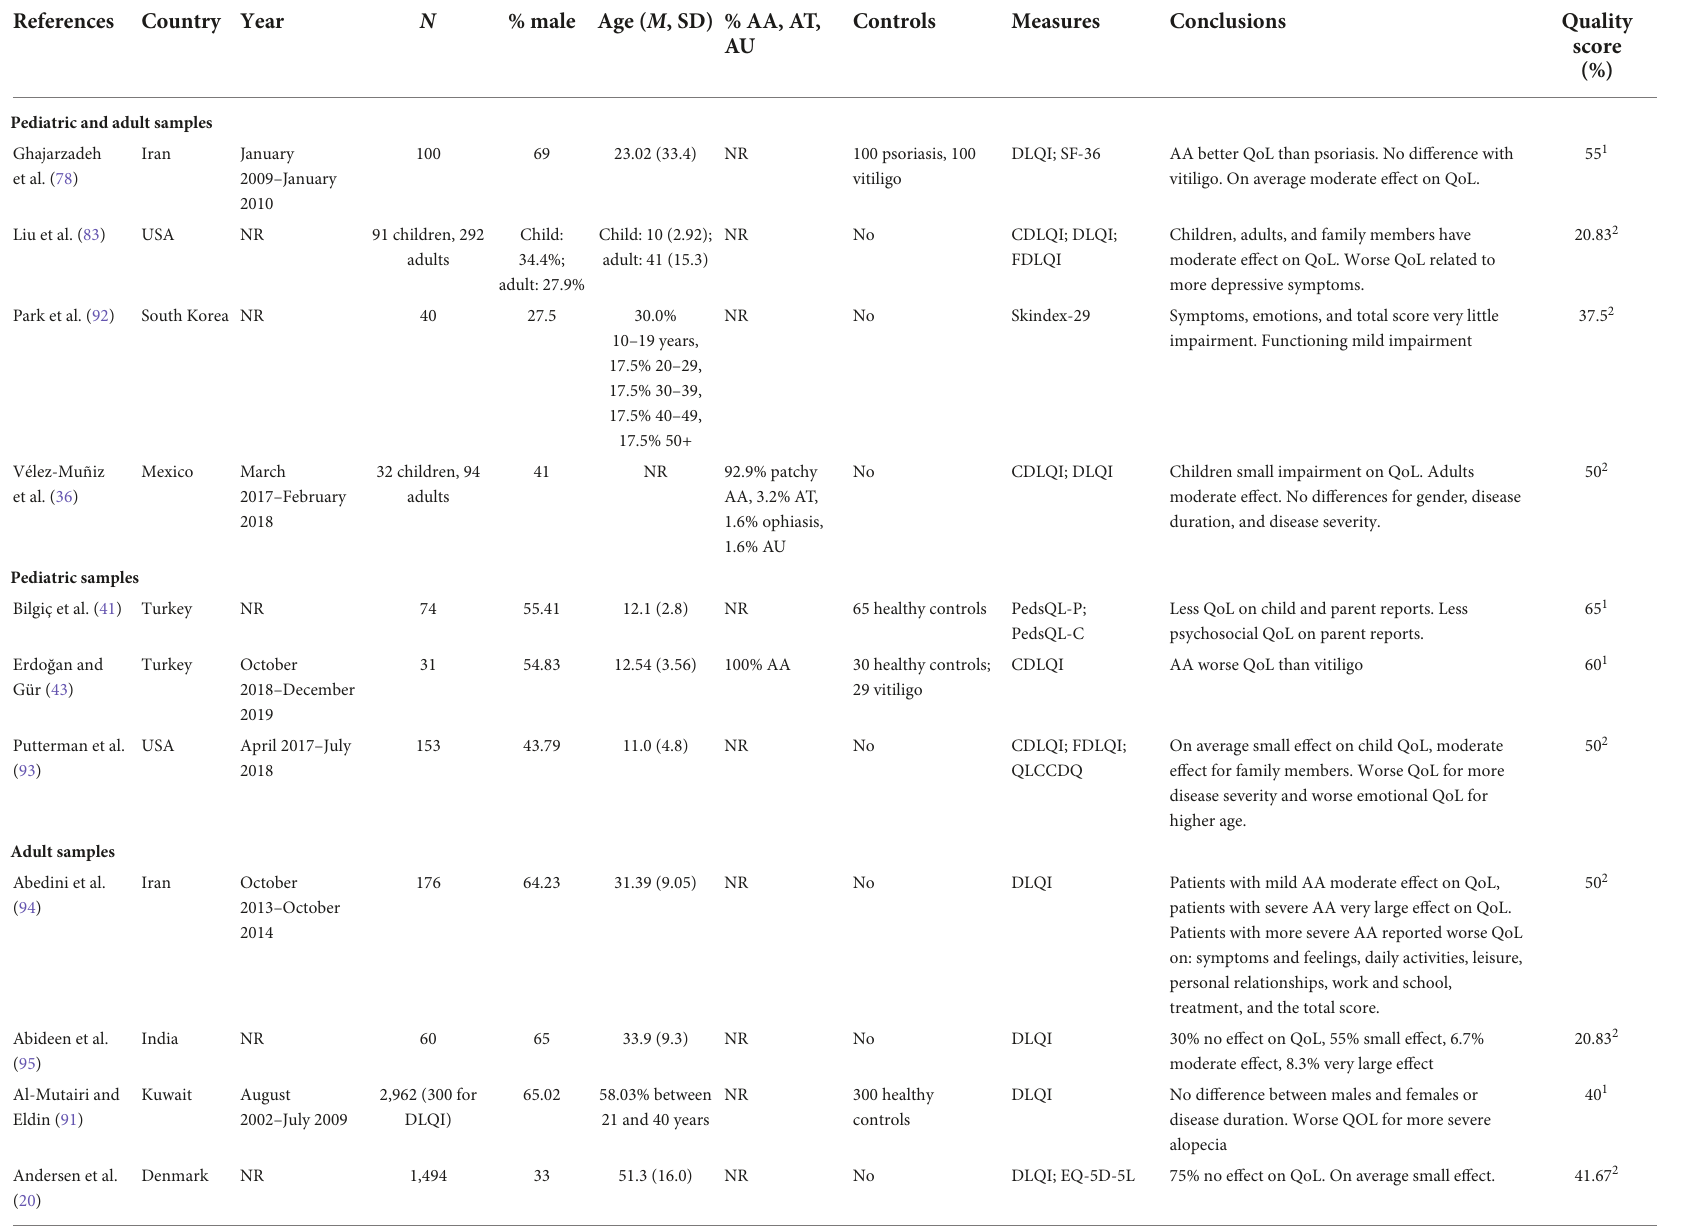
TABLE 3 Results for quality of life.